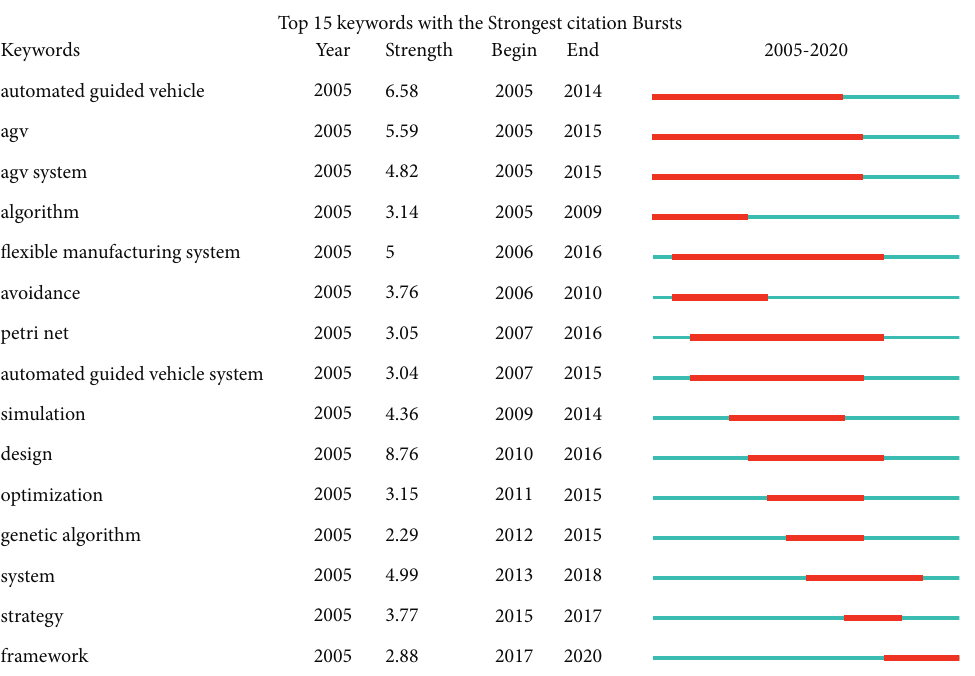
Figure 10: Keyword burst